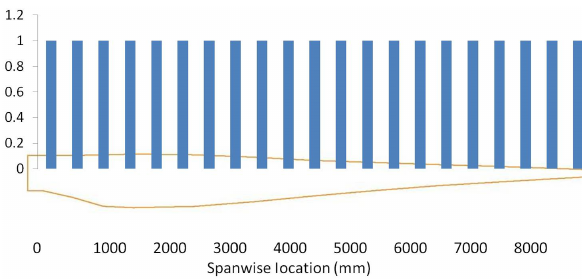
Figure 13. Probability mass of 100% that a flaw is located at each blade location used in Case 2.